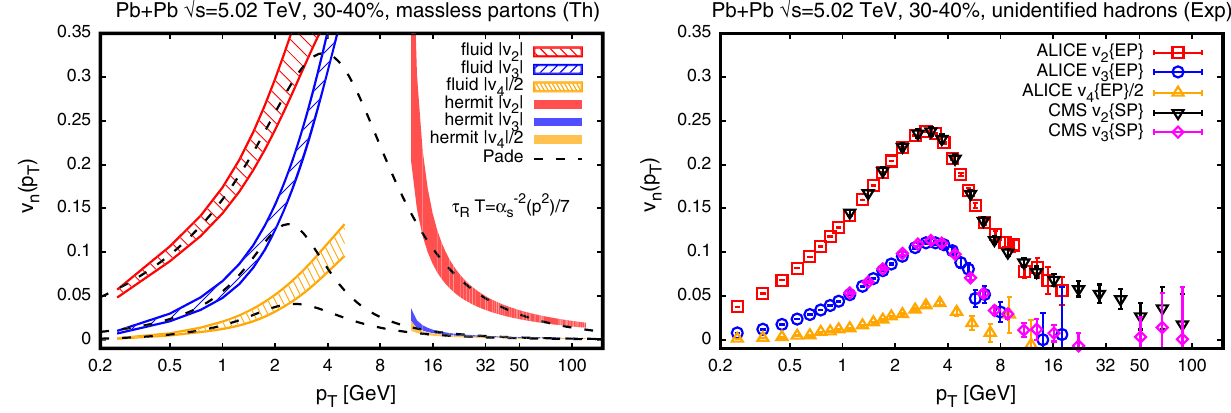
Fig. 4 Left: Results for momentum anisotropy coefficients (cid:9) v n ( p T ) (cid:10) for massless partons from theoretical calculations at low momenta (zeroth order hydrodynamic gradient expansion) and high momenta (first order eremitic expansion). For illustration, low and high momen-